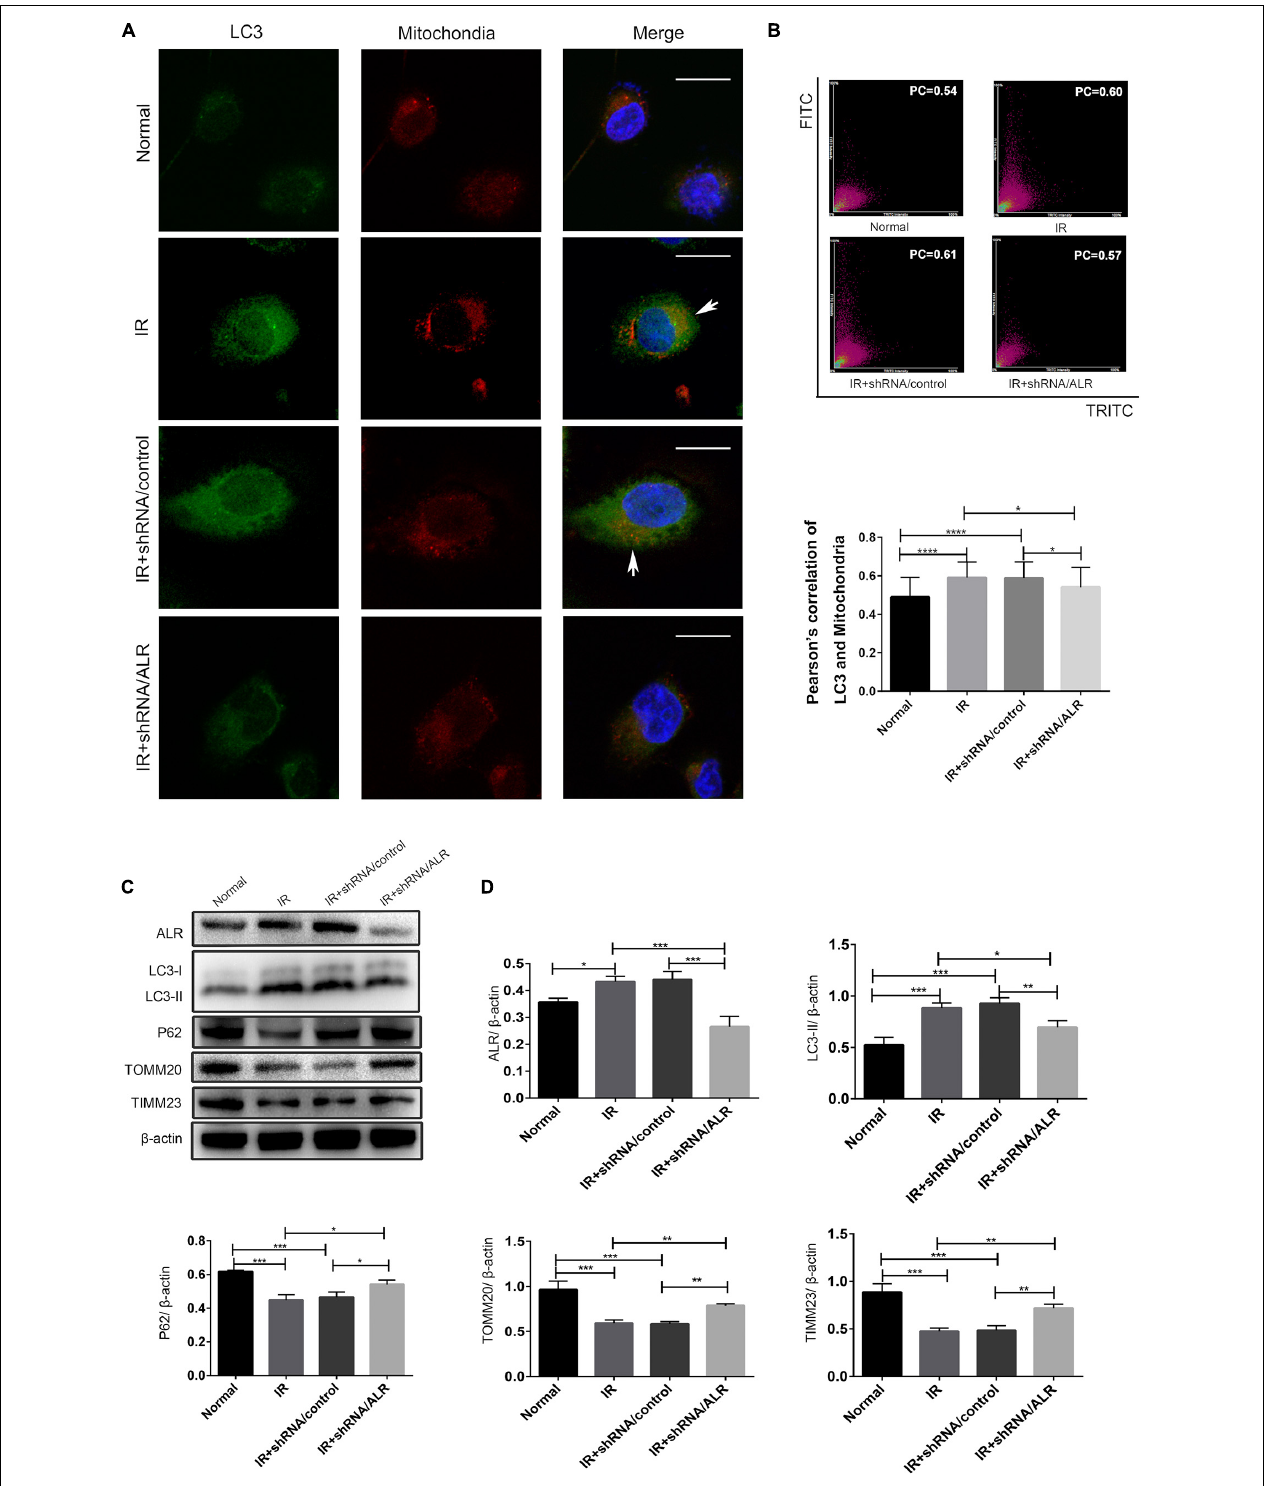
FIGURE 4 | Silencing of augmenter of liver regeneration (ALR) inhibited ischemia–reperfusion (I/R)-induced mitophagy in HK-2 cells. (A,B) Representative images and quantification of immunofluorescence double-labeling LC3B and translocase of outer mitochondrial membrane 20 (TOMM20) in different groups. TOMM20-labeled mitochondria (red) and LC3-labeled autophagosome (green). Scale bar: 50 µ m. the Pearson’s correlation columns were shown in bar graph format. Sixty cells from three independent experiments were analyzed. (C,D) Immunoblot analysis and quantification of ALR, LC3, P62, TOMM20, and translocase of inner mitochondrial membrane 23 (TIMM23). Data represent the means ± SD. n = 3. * p < 0.05, ** p < 0.01, *** p < 0.001, **** p < 0.0001.